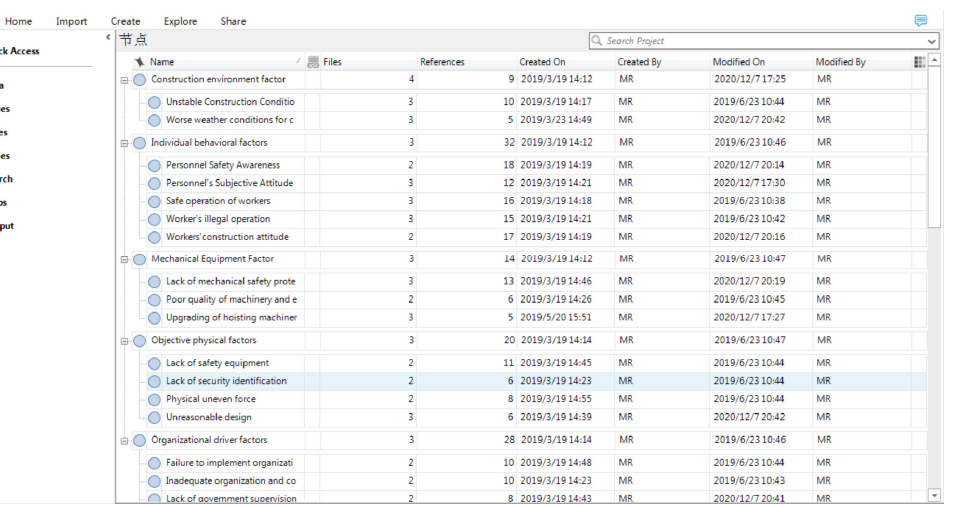
Figure 3. Selective coding results by using Nvivo12 (Part 1). The Chinese in the picture means